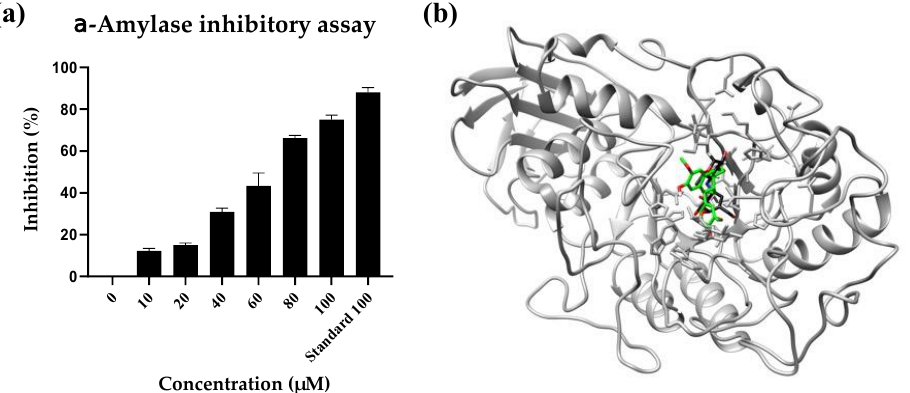
Figure 4. Effect of ferruginan on α -amylase activity at various concentrations. Acarbose was used as a standard; the experiments were performed in triplicate, and the values are reported as mean ± SD ( a ). Representative model showing the interaction of ferruginan (green, docked pose −7.6 kcal/mol), in comparison with co-crystallized acarbose (black), with α -amylase (1B2Y, artwork produced with UCSF Chimera) ( b ).